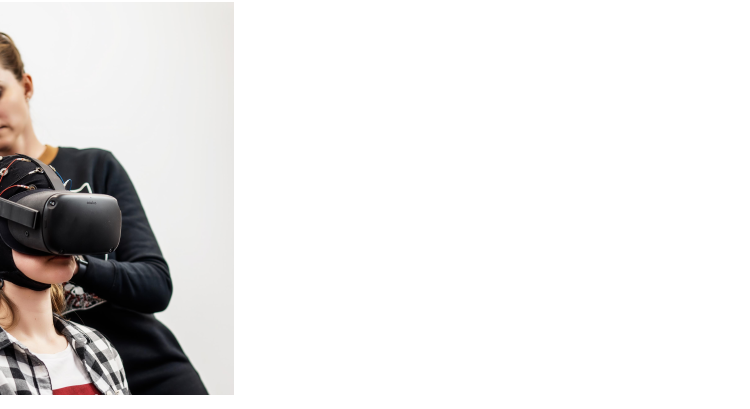
Figure 2. The process of mounting EPOC Flex headset and VR HMDs.